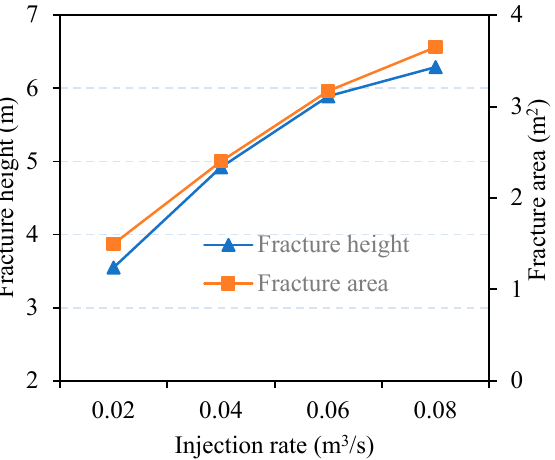
Figure 14. Variation in fracture height and fracture area versus injection rate.